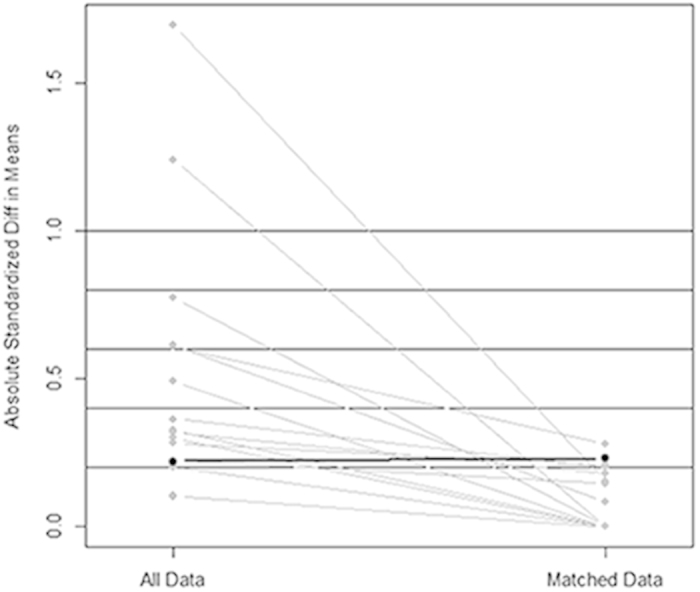
Parallel line plot of the standardized difference in means before and after PSM in patients with benign and malignant fGGOs.As the standardized difference in means was reduced, covariate balance was improved in the matched samples.